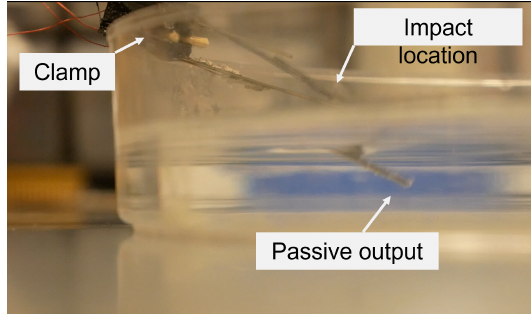
Figure 14. Amplification mechanism with output passive beam immersed in water.